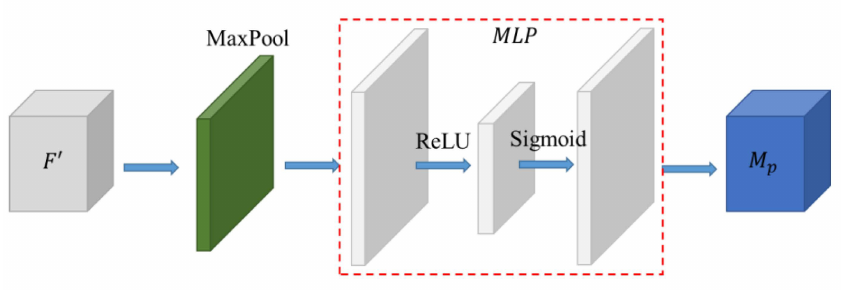
Figure 8. Point cloud attention